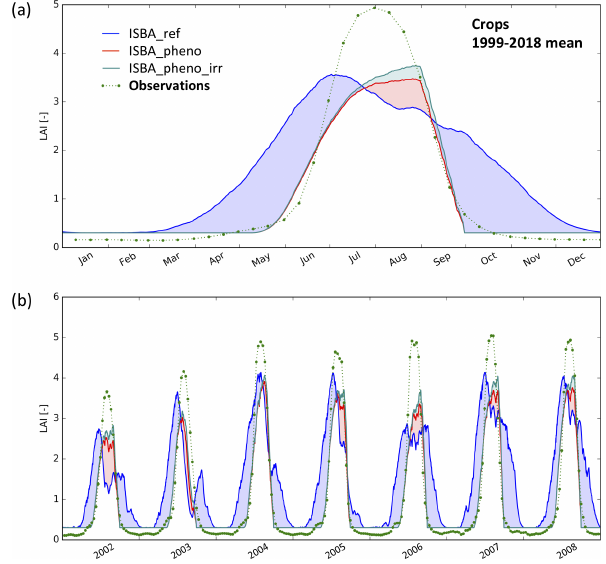
Figure 4. LAI (m 2 m − 2 ) of irrigated crops (C 3 or C 4 ) in the most densely irrigated part of Nebraska (Fig. 2e). (a) Seasonal varia- tion for the time period from 1999 to 2018. (b) Daily time se- ries from 2002 to 2008. Simulated LAI is shown for the irri- gated fraction, from the reference simulation (ISBA_ref, blue line), and from the simulations with only agricultural practices and with agricultural practices and irrigation (ISBA_pheno, red line, and ISBA_pheno_irr, cyan line, respectively). Satellite-derived LAI ob- servations (green dots) are for areas where the fraction of C 3 or C 4 irrigated crops is larger than